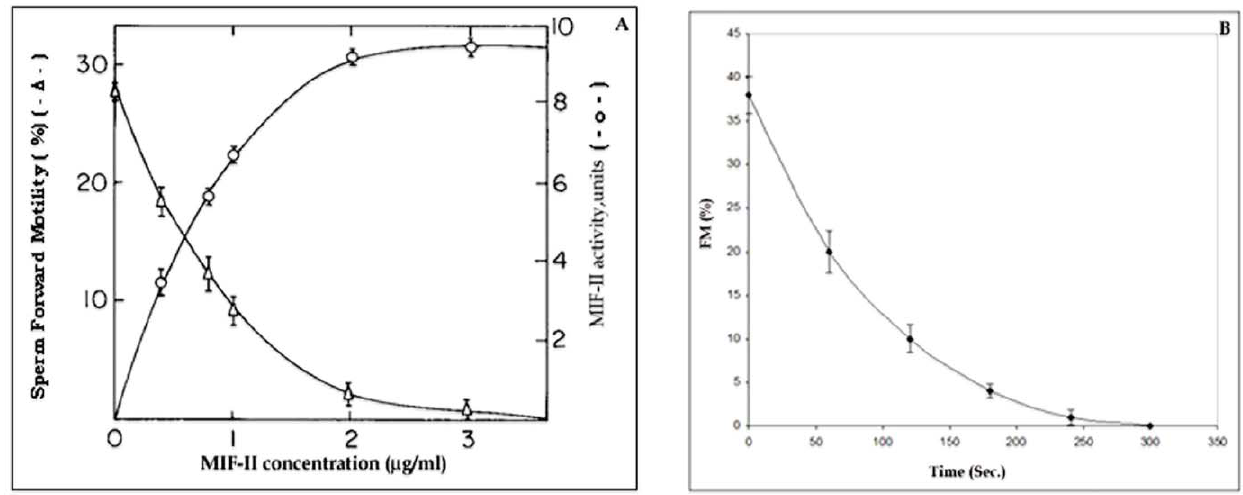
Figure 5. Dose course and time course of MIF-II. A) Dose course of action of purified MIF-II under the standard assay conditions. B) Time course of the action of MIF-II under the standard assay conditions. Amount of MIF-II used was 2 m g/ml. The data shown are mean 6 SEM of three experiments.